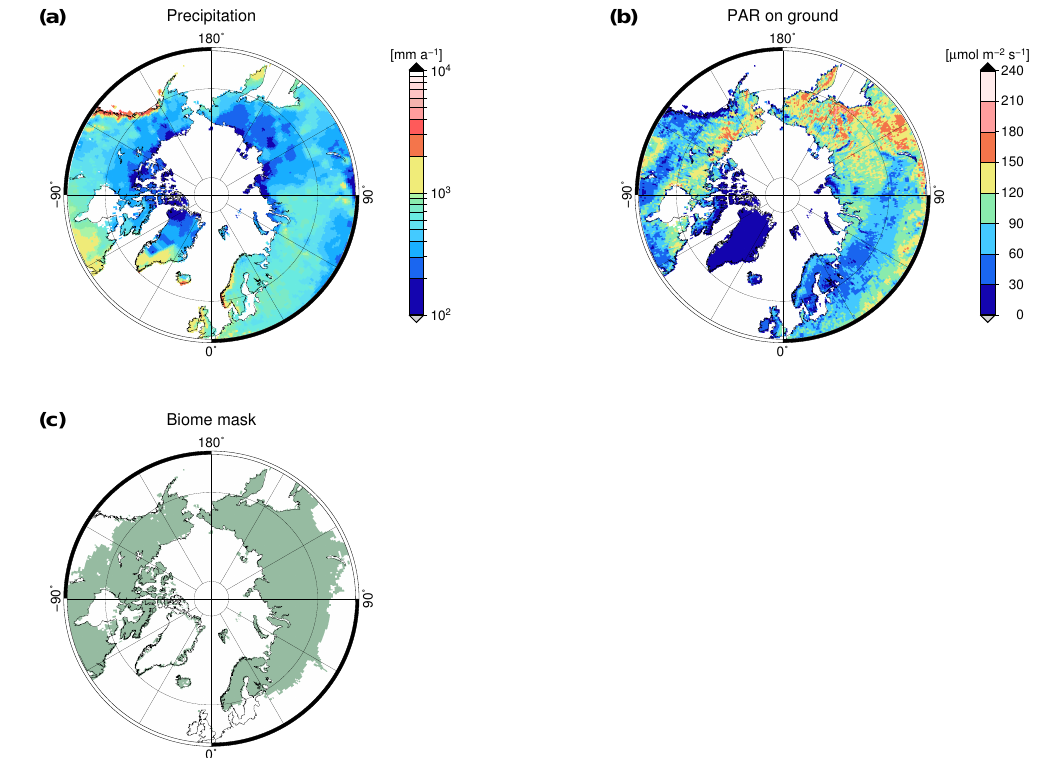
Figure B2. Additional model output, averaged over the last 15 years of a JSBACH transient simulation from 1901 to 2010. Spatial patterns of (a) precipitation and (b) photosynthetically active radiation (PAR) on the ground. Note that PAR on ground is a variable of LiBry in JSBACH, it is, therefore, only larger than zero where bryophytes and lichens exist in the model. (c) shows the biome mask based on Olson et al. (2001) which is used to constrain our estimates to boreal forest and